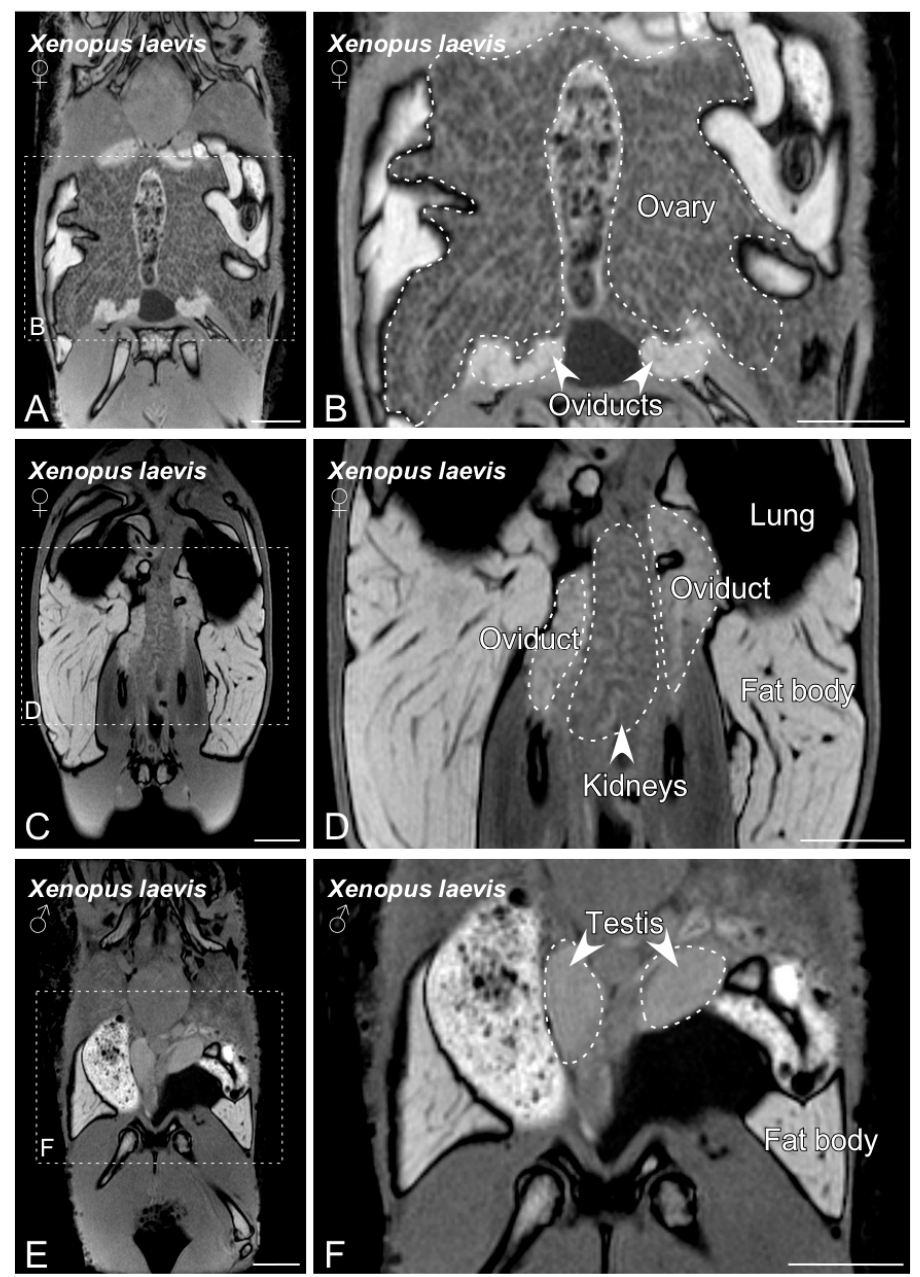
Figure 3. MRI slices selected to illustrate the main sex organs of the Xenopus laevis anurans. Images from ( A ) to ( D ) show the structures identified in a gravid Xenopus laevis female. Images ( E , F ) show testis and fat body in a Xenopus laevis male. The dashed lines in ( A , C , E ) indicate the magnification photos showed in ( B , D , F ). Scale bars = 1 cm.